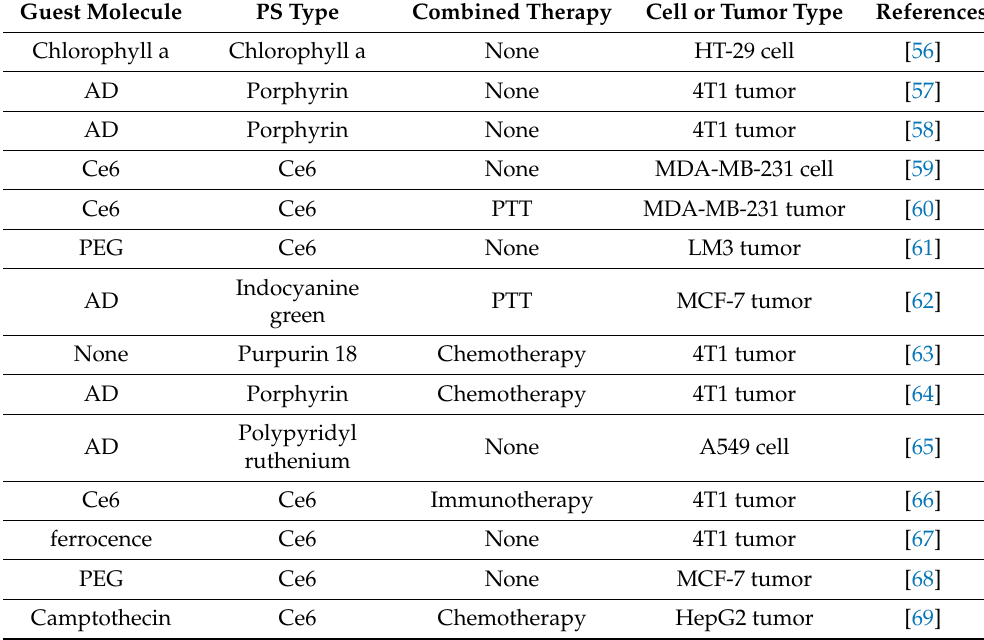
Table 2. A summary of the CD-based PDT